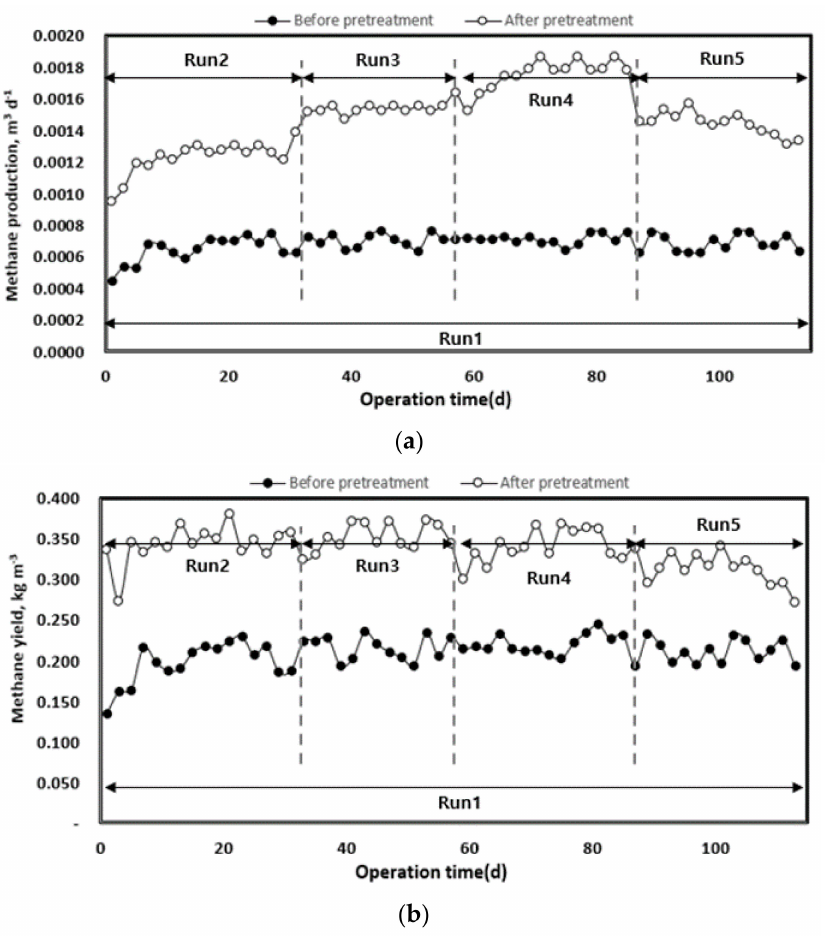
Figure 8. Change in methane production ( a ) and yield ( b ) according to operation